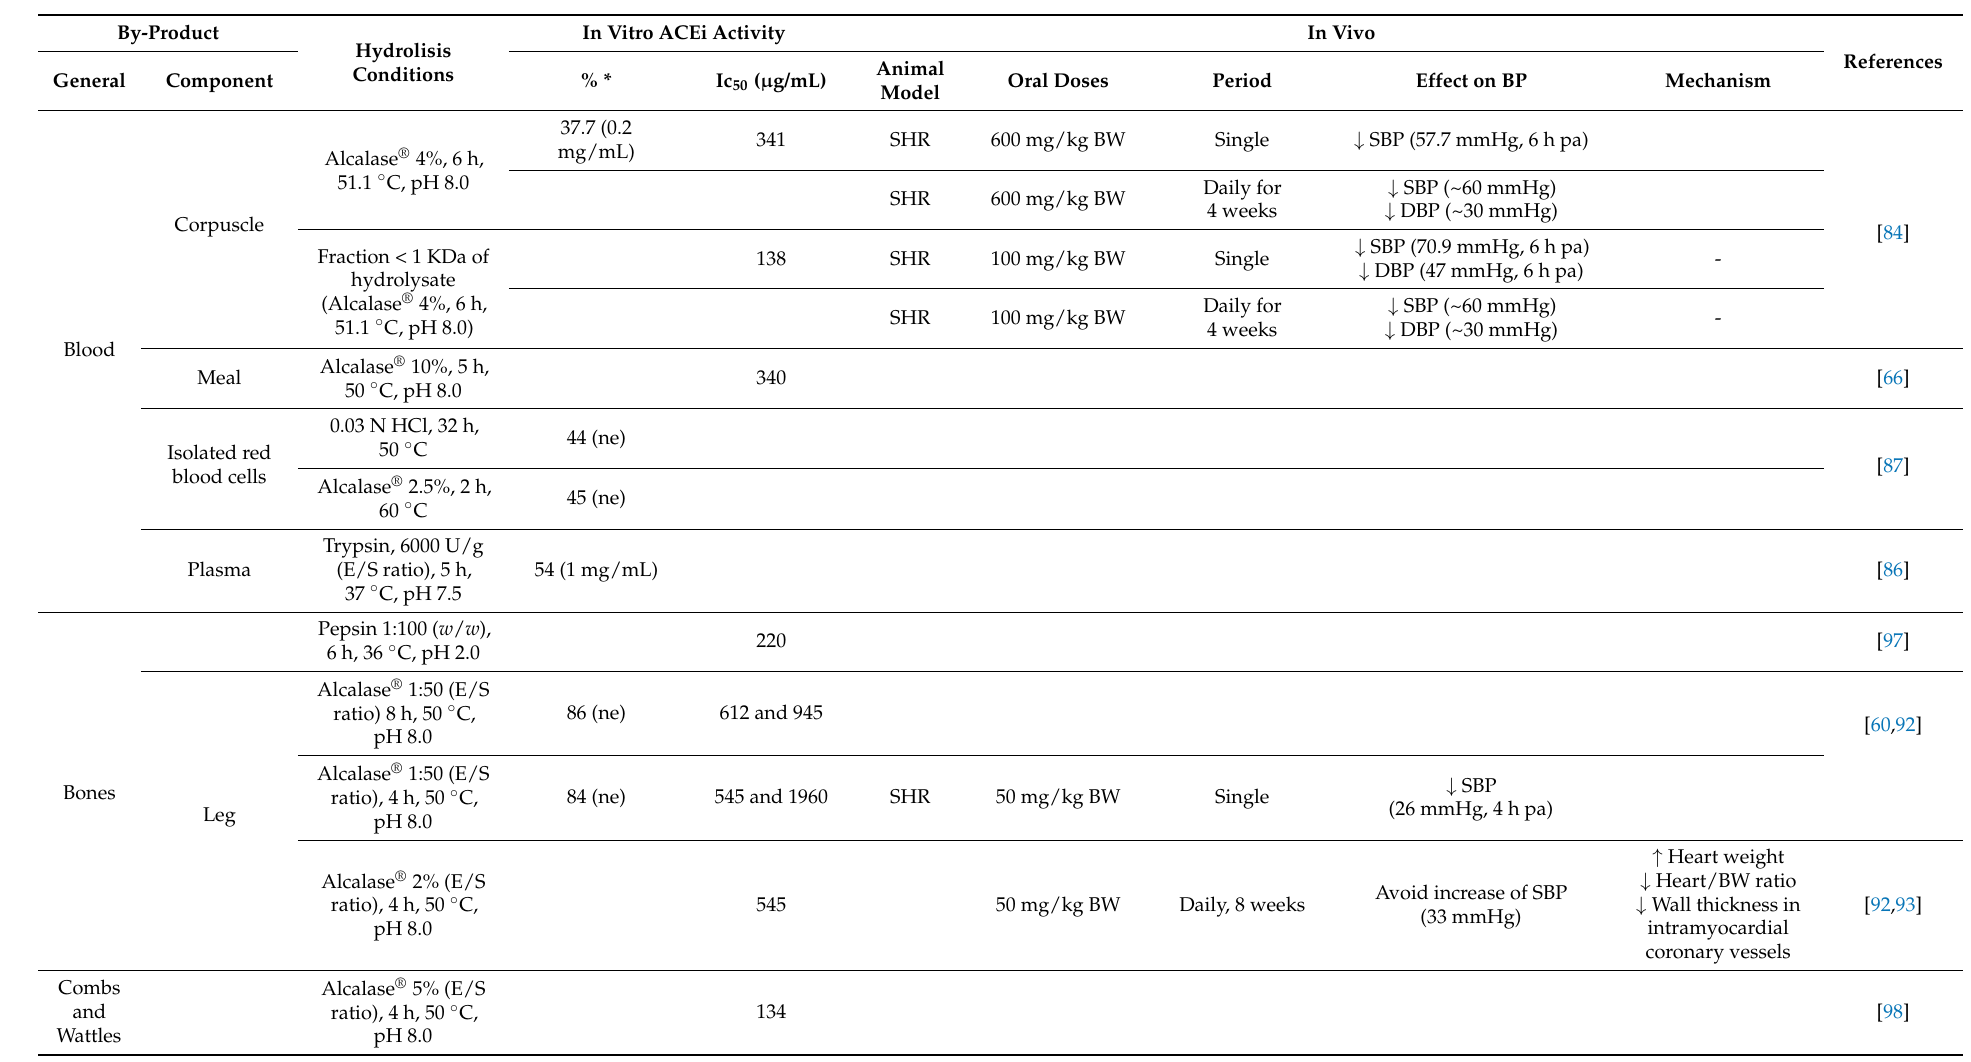
Table 2. Angiotensin-converting enzyme inhibitory and antihypertensive activities shown by the hydrolysates obtained from chicken